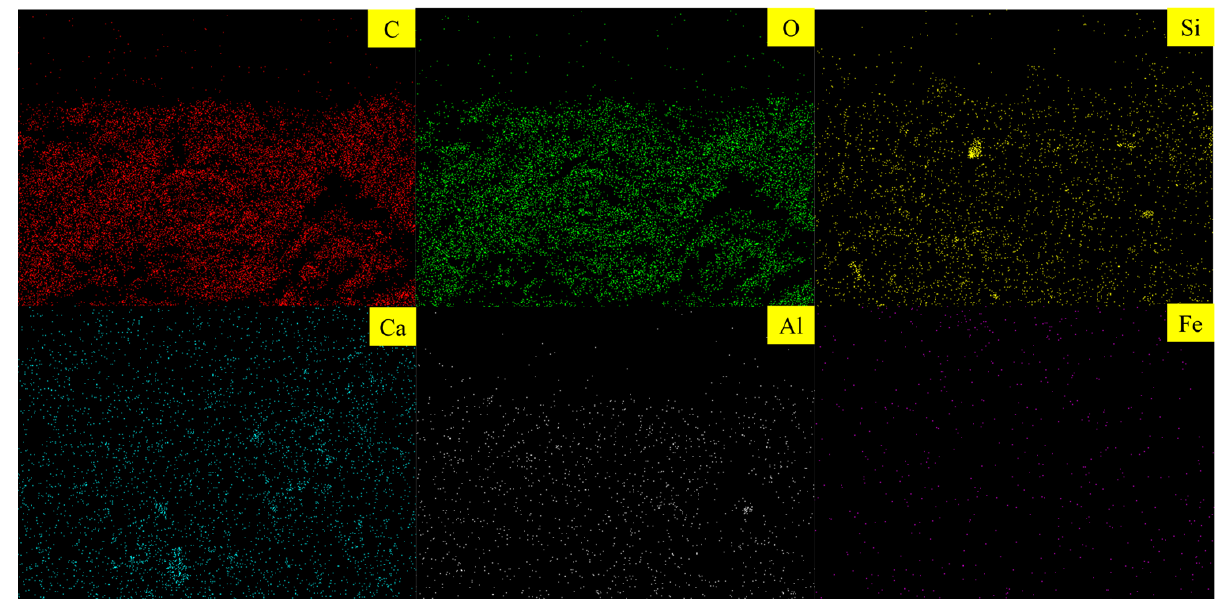
Figure 5. Elemental composition of YDA obtained from EDX.